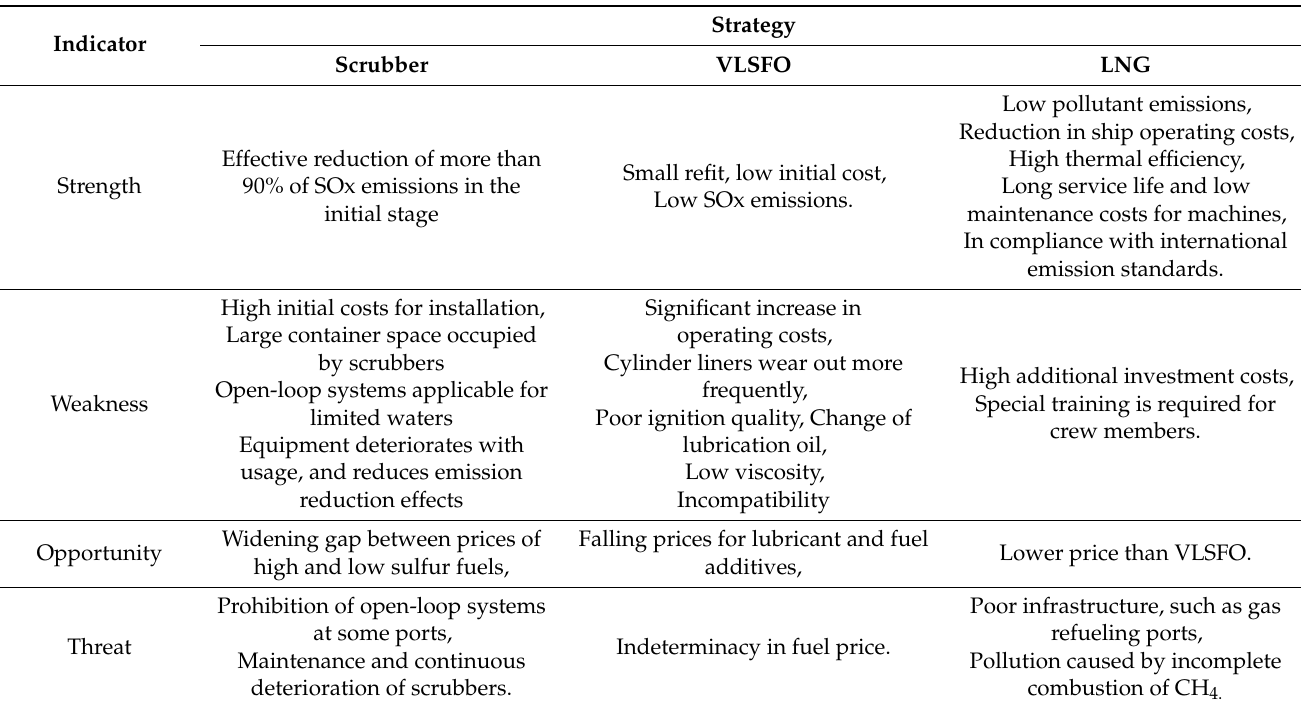
Table 2. Results of SWOT analysis of three feasible